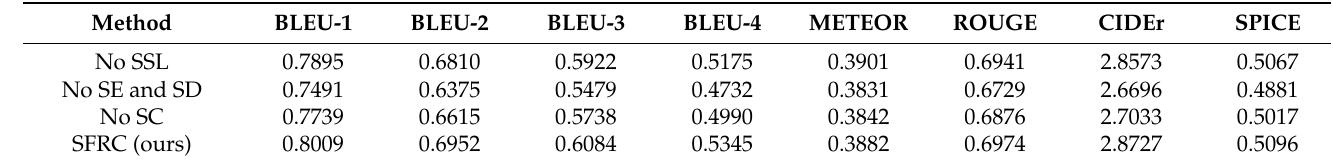
Table 12. Comparison of evaluation metric scores of methods for removing different components on RSICD